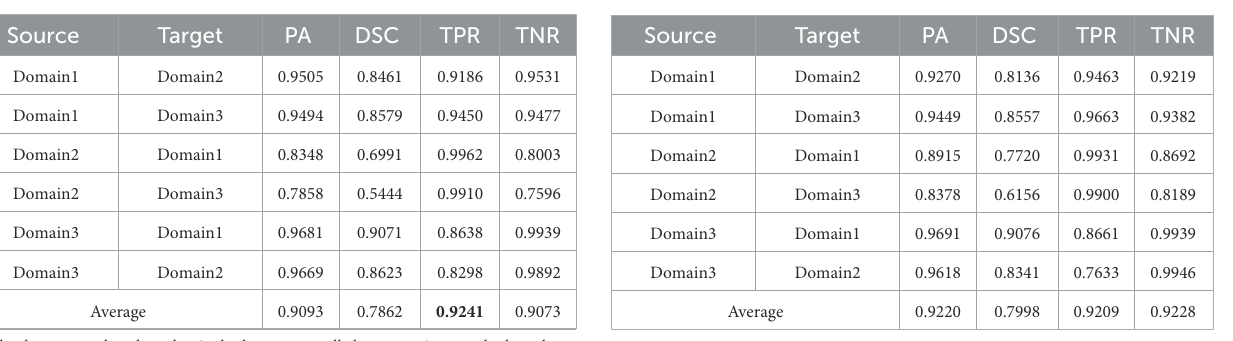
TABLE 1 Results on ultrasound thyroid nodule datasets with DeepLabV3 (41) +AUG.